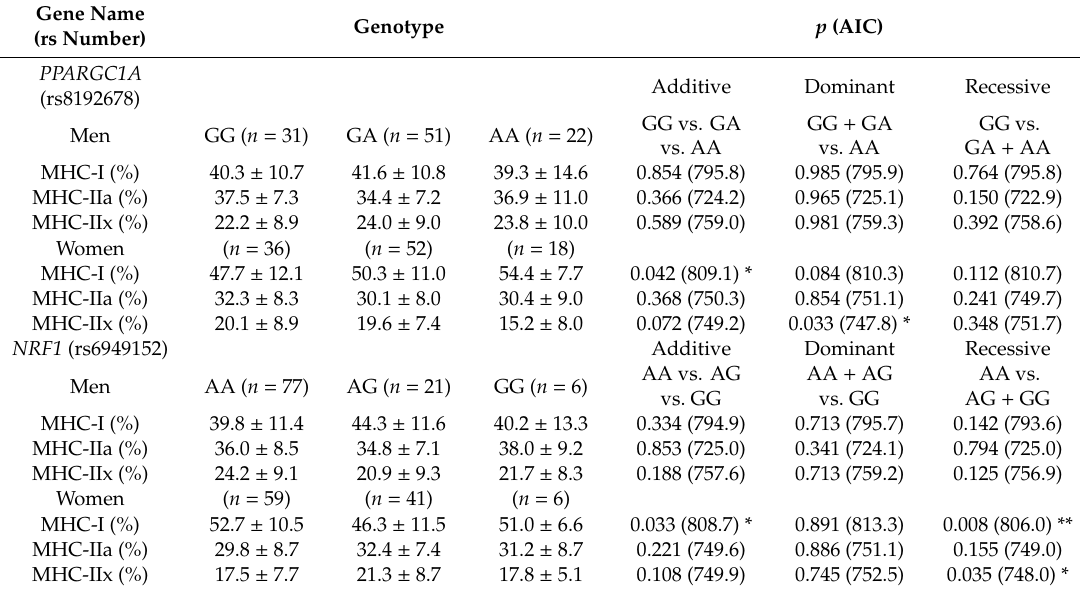
Table 2. Associations of PPARGC1A rs8192678 G / A (Gly482Ser) and NRF1 rs6949152 A / G polymorphisms with MHC-I, -IIa, and -IIx content in men and